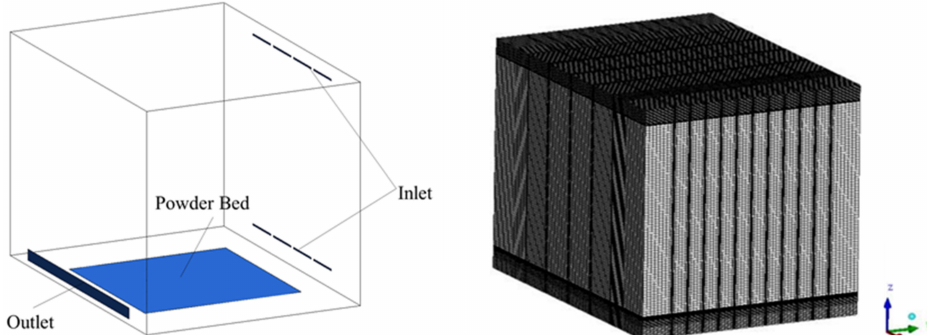
Figure 2. The geometry of the shielding gas flow volume and the mesh of the volume.